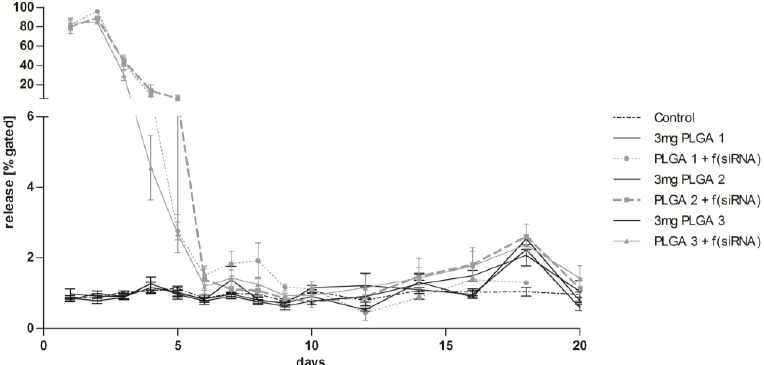
Figure 8. Long-term release of siRNA AF 488 complexes and the conditional transfection efficiency in EA.hy926. Glass slides were coated four times with alternating layers of 0.5 mg PLGA and 3 µg siRNA AF 488 with a capping layer of 1 mg PLGA. In the first 10 days, slides were transferred to new confluent cells every day. From day 11, slides were changed every second day. As control samples, cells without a slide and slides coated with 3 mg PLGA only were used. Uptake of siRNA was measured by flow cytometry. f(siRNA) = fluorescence-labeled siRNA. Statistical analysis was performed by an outlier test (alpha = 0.05) and test for normal distribution before the ANOVA. Each bar represents the